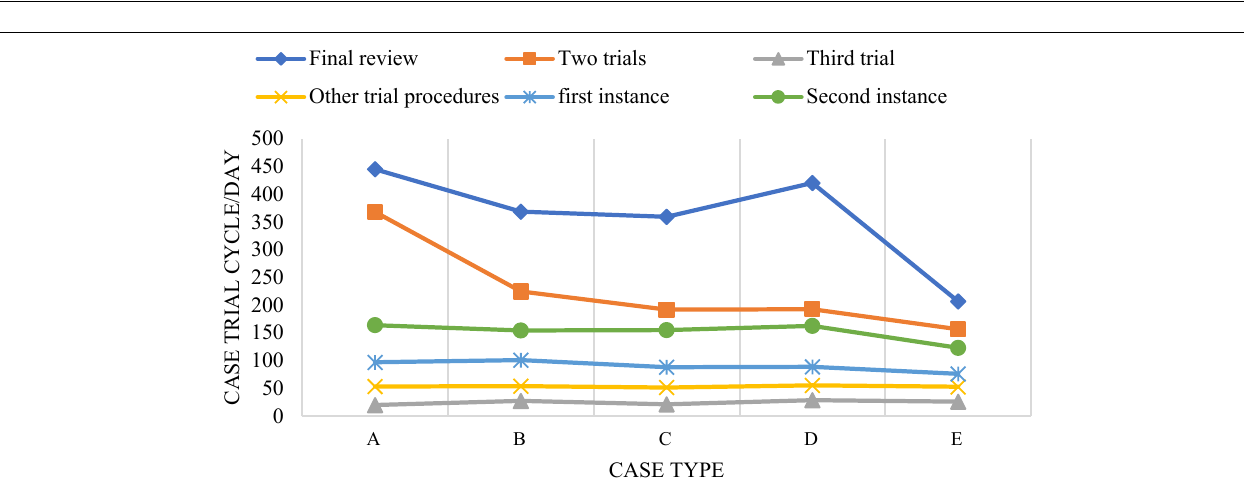
by the visible layer is expressed as equation